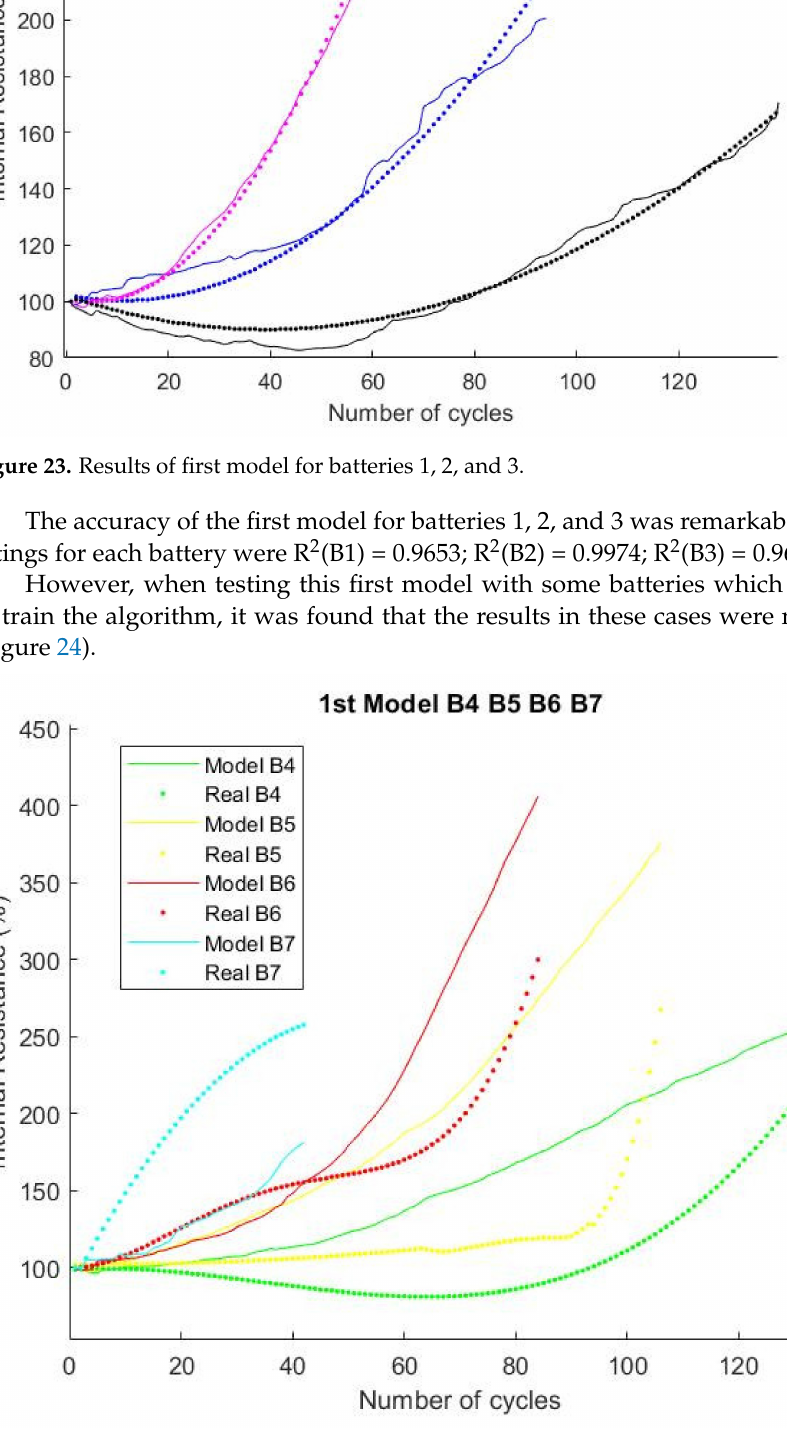
Figure 24. Results of first model applied on batteries 4, 5, 6, and